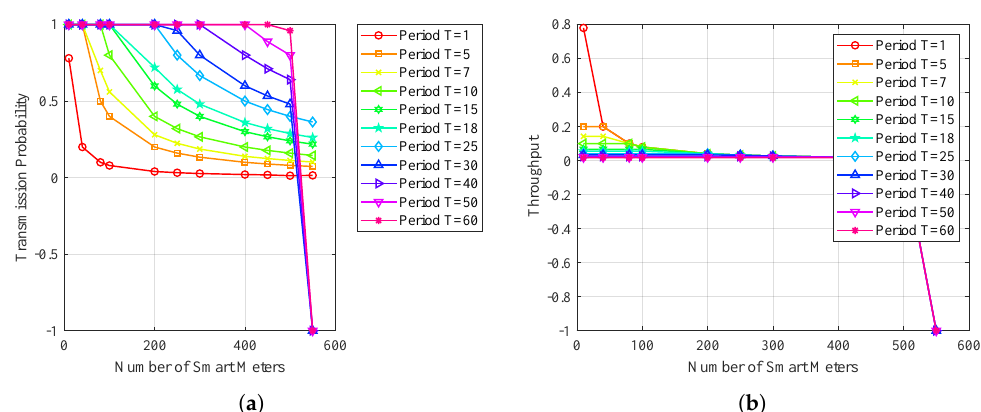
Figure 6. Opportunistic transmission to serve smart meters. ( a ) Transmission probability/# smart meters; ( b ) smart meter reading period (T).